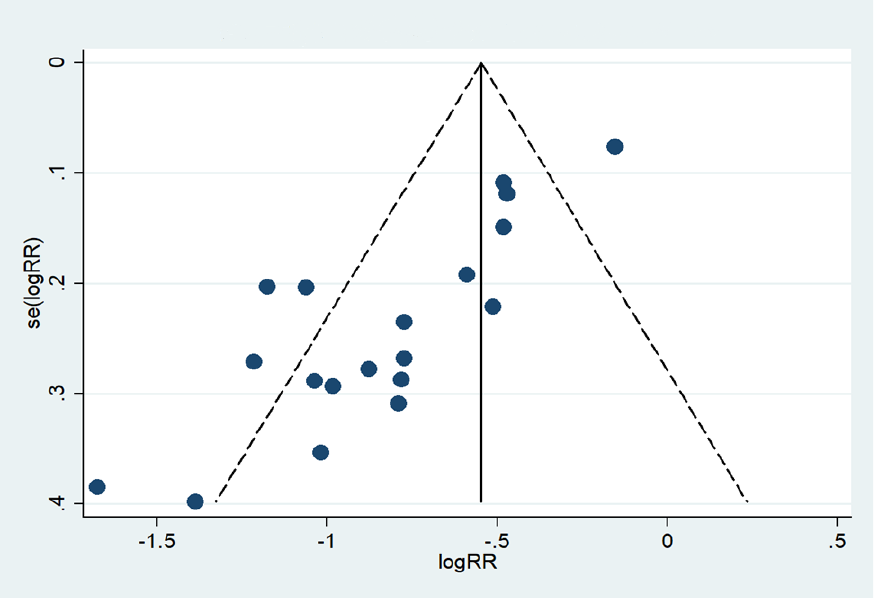
Figure 5 : A funnel plot was used to evaluate the publication bias for 5-hydroxytryptamine 3 receptor antagonists in reducing propofol injection pain. (SE, standard error; RR, risk